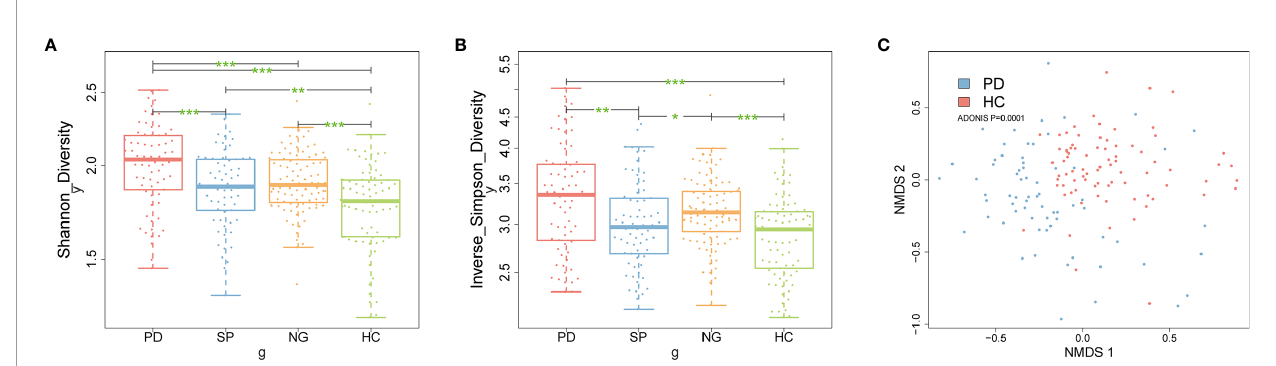
FIGURE 2 | Microbial community differences between PD patients and control subjects. (A, B) Box plots describe differences in the microbiome diversity indices between PD and control groups according to the Shannon and inverse Simpson diversity indexes based on OTU levels. Each box plot represents the median, interquartile range, minimum, and maximum values. (C) Non-metric multidimensional scaling (NMDS) analysis of samples from PD group and HC group. Ordination based on Bray-Curtis dissimilarity calculated with genus-level data. Each dot represents one sample, the closer the dots are to one another, the more similar the microbiome compositions of these samples. *P < 0.05, **P < 0.01, ***P < 0.001 by the Wilcoxon rank-sum test. PD, Parkinson ’ s disease; SP, spouse of PD patients; NG, normal group; HC, healthy control; OTU, operational taxonomic